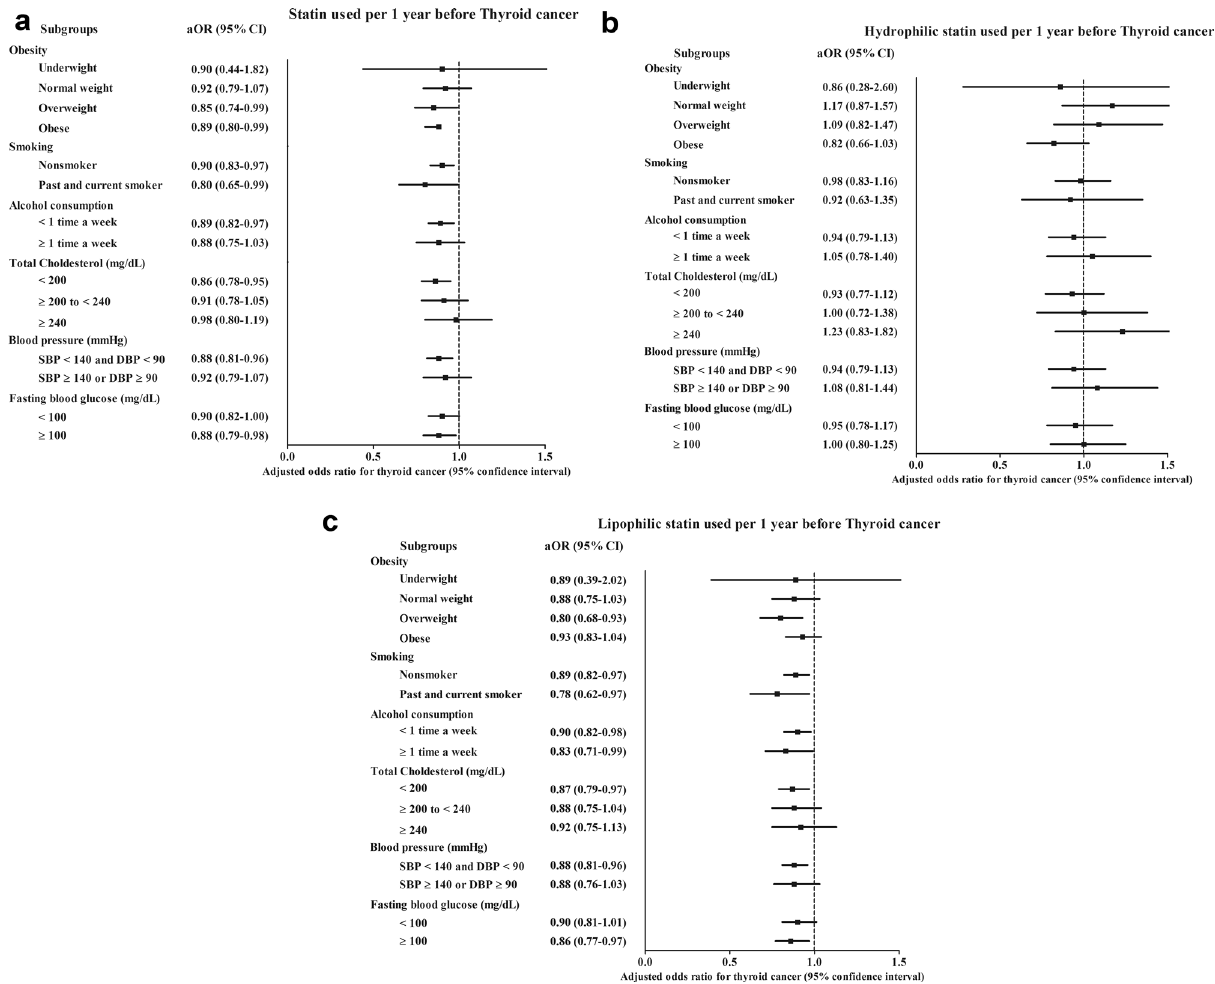
Figure 2. The odds ratios (95% confidence intervals) of ( a ) statin, ( b ) hydrophilic statin, and ( c ) lipophilic statin use for thyroid cancer according to obesity, smoking, alcohol consumption, total cholesterol, blood pressure, and fasting blood